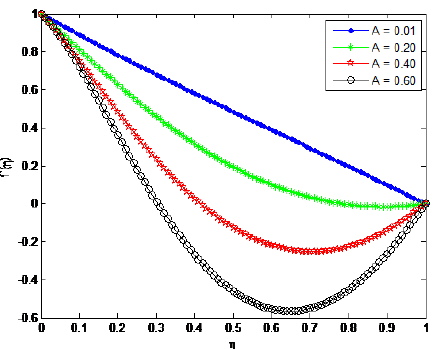
Figure 11. Influence of suction term on dimensionless velocity